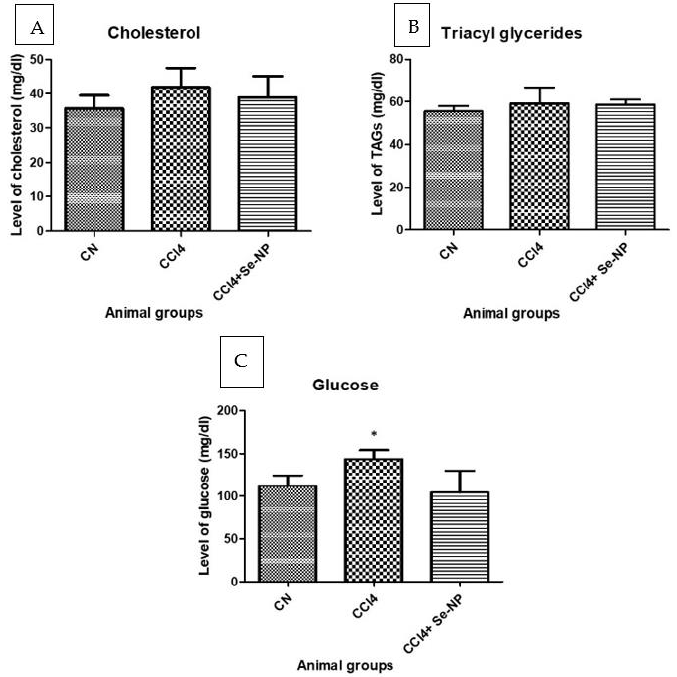
Figure 5. Showing level of total cholesterol ( A ), triglycerides ( B ), and glucose concentrations ( C ) in the plasma from different rat groups. * ( p -value < 0.05) indicates significant differences in different rat groups in comparison to control (CN) group animals.